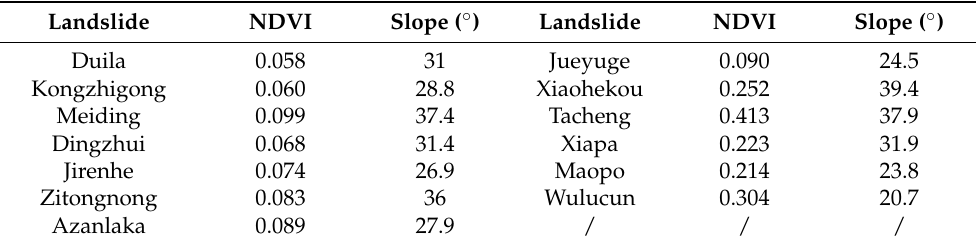
Figure 4. The NDVI value ( a ) and slope ( b ) of the study area. Table 2. Vegetation coverage and slope of potential